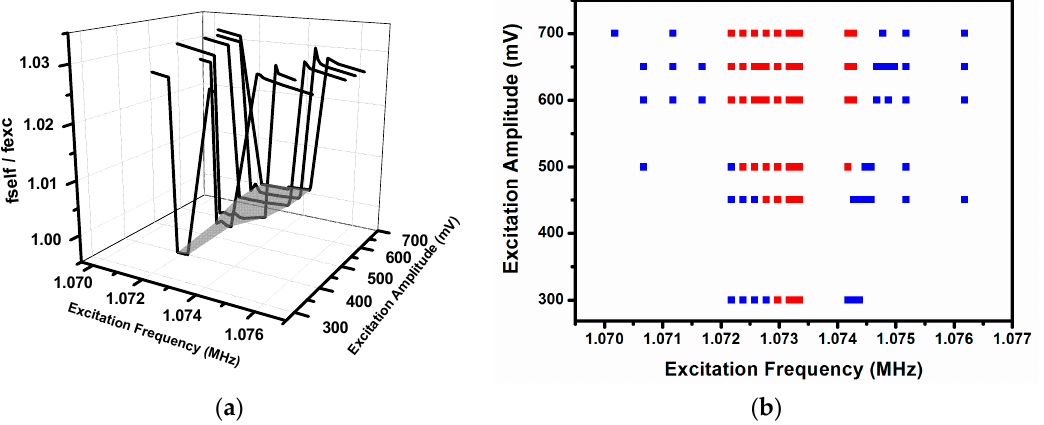
Figure 12. ( a ) Ratio between self-oscillation and excitation frequencies ( fself / fexc ) for different amplitudes of the excitation and 24 V DC of applied voltage. Here, the excitation is applied at cantilever number 4. The synchronized zone appears as a plateau for which the ratio fself / fexc takes the unit value (shaded gray zone); ( b ) A 2D representation of the previous figure, in which the red squares represent the minimum ratio of fself / fexc and the blue ones the maximum. We can see that the rage of excitation frequencies into the synchronized zone widens with the amplitude of the excitation. In the case of applying the external force with the same frequency at which the self-sustained system oscillates (the frequency of the self-oscillation in a closed-loop configuration), we